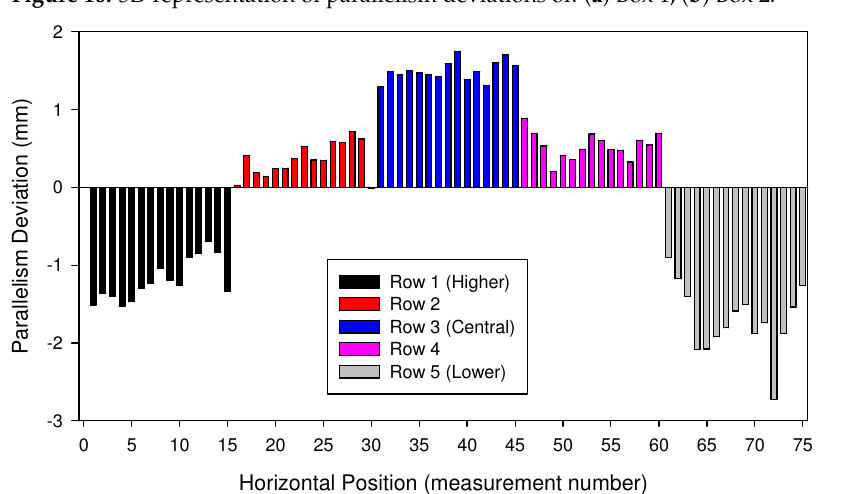
Figure 10. 3D representation of parallelism deviations of: ( a ) Box 1; ( b ) Box 2.